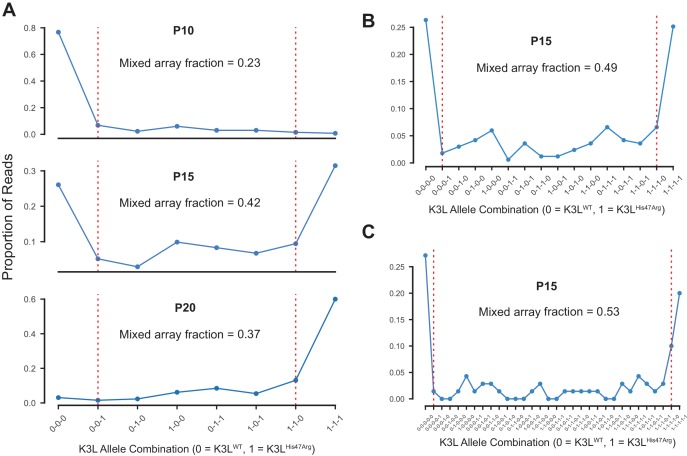
Multicopy K3L arrays contain diverse combinations of K3LWT and K3LHis47Arg alleles.(A) The proportions of 3-copy K3L arrays containing each possible combination of K3LWT and K3LHis47Arg alleles at P10, P15, and P20 were counted. Dotted red lines separate mixed and homogeneous arrays, and the total fraction of mixed arrays is indicated above each plot. The proportions of (B) 4-copy and (C) 5-copy arrays with each possible combination of K3L alleles are shown for passage 15, which was re-sequenced to generate a larger number of reads.